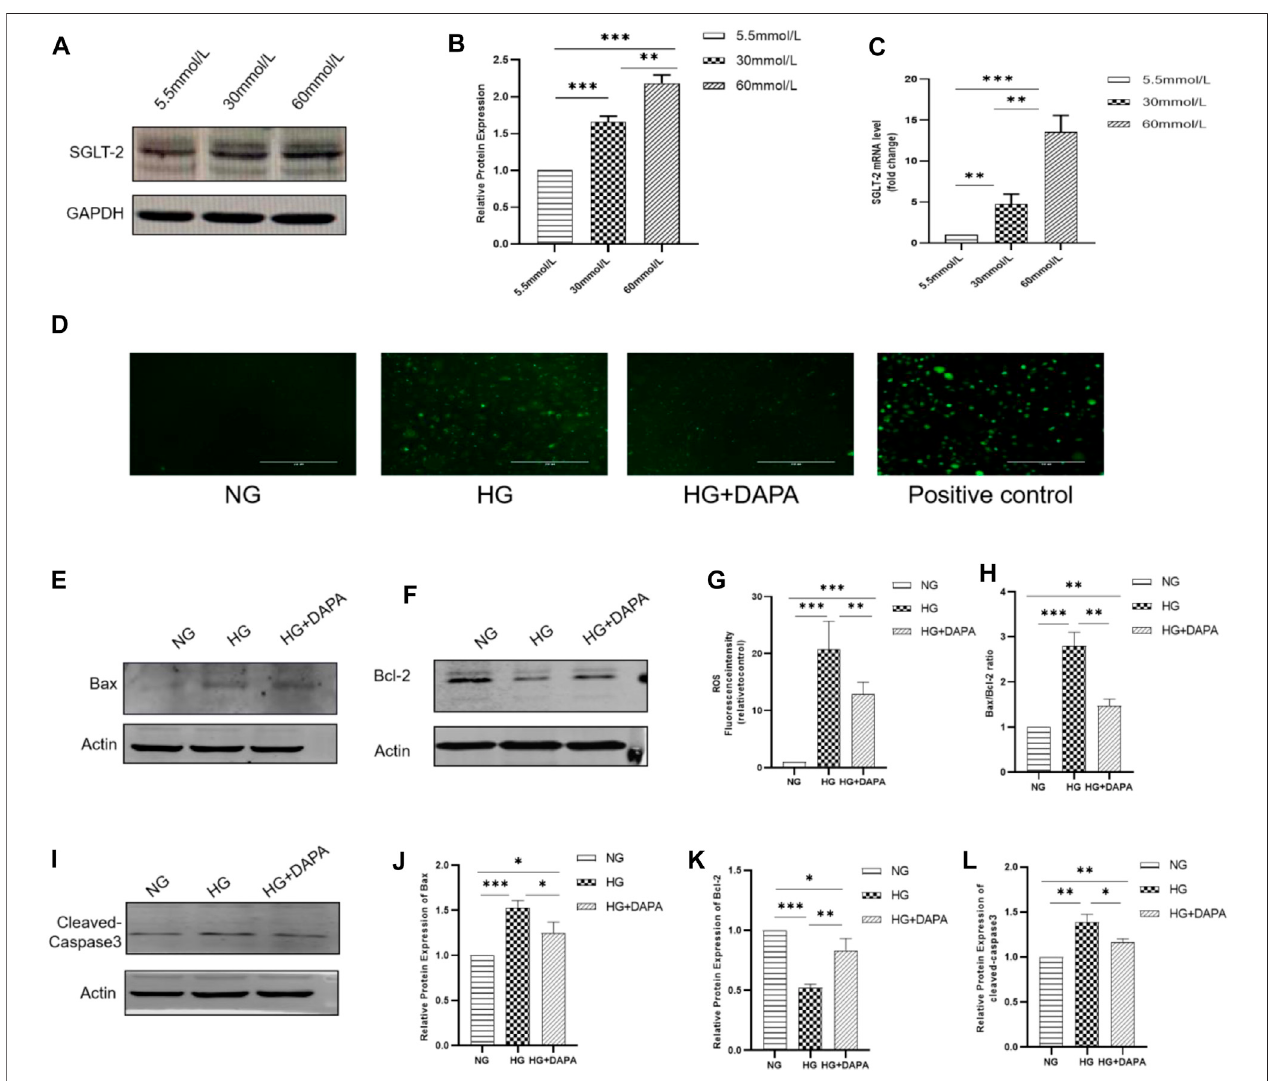
FIGURE 3 | Expression of SGLT-2 in HRMECs and effect of DAPA on ROS and apoptosis of HRMECs. (A,B) Determination of SGLT-2 expression in HMRECs by WB. (C) DeterminationofSGLT-2mRNAexpressioninHMRECsbyRT-PCR. (D,G) TheeffectofDAPAontheproductionofROS. (E,F,H,I – L) Theproteinexpressionof BAX, Bcl-2, and cleaved-caspase-3 was evaluated by WB. Data are presented as means ± SD. * p < 0.05, ** p < 0.01, *** p < 0.001.